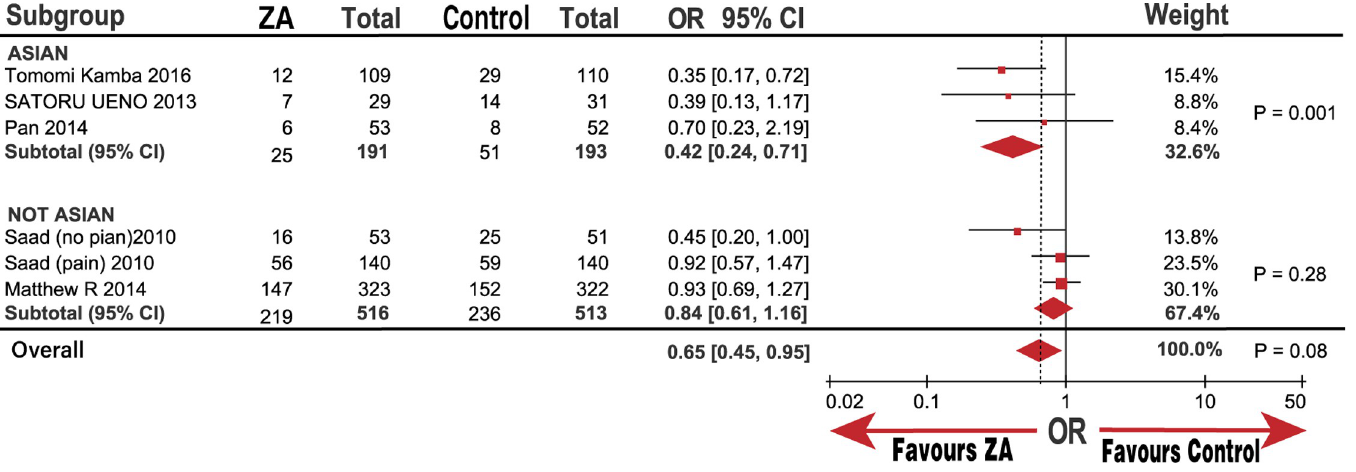
Fig 8. Forest plot odds ratio (OR) of Skeletal related events (SREs) in subgroup of Asian and not Asian.